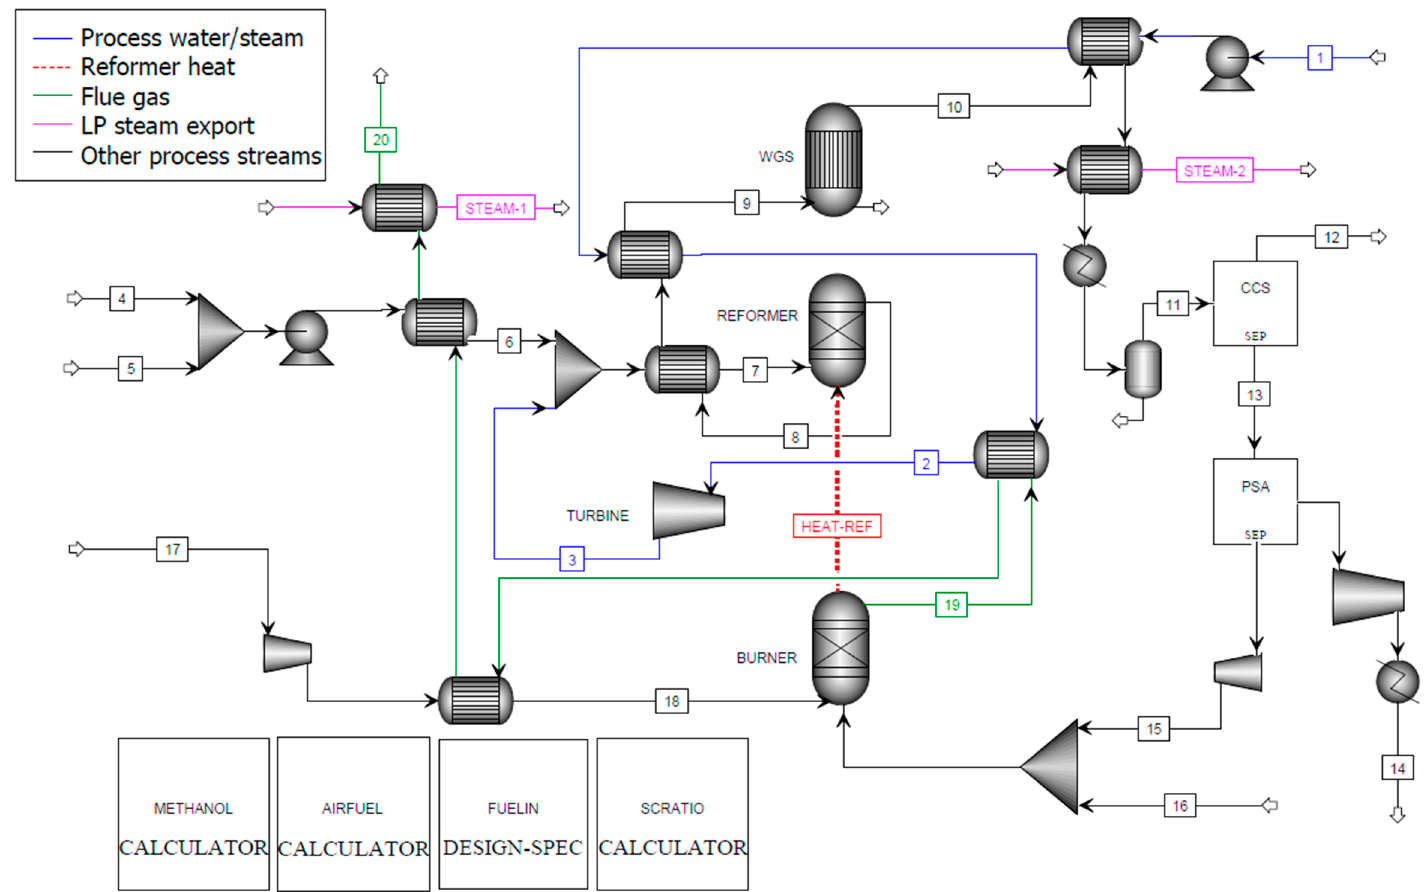
Figure 3. Aspen Plus flowsheet for C-SR of bio-oil with CO 2 capture.